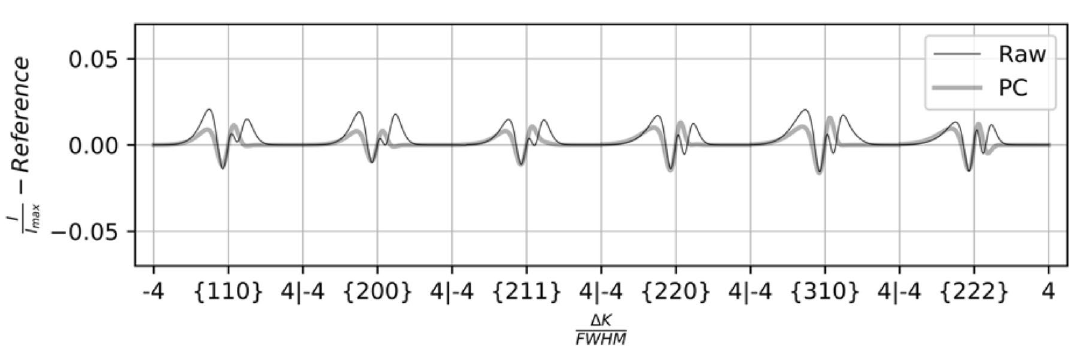
Figure 9. Actual and PC representation of the peak shape variations from a reference peak shape of a bimodal profile with a heterogeneity value of ensure high signal to noise ratio. Line profile data were collected for all deformed samples compressed to various levels of final strains. The six peaks with largest interplanar spacing were selected for analysis: {110}, {200}. {211}, {220} {310}, and {222}. Two profiles are shown for reference in Fig. 10. In Fig. 10, the relative intensity of the peaks to the background and noise is shown to be high, and the breadth of peaks was variable between samples. The increase in peak breadth was apparent with increasing macroscopic strain. The peak broadening was asym- metrical for many of the peaks analyzed. Data‑driven methods. DDD microstructure synthesis. Discrete dislocation dynamics (DDD) simulations represent a dislocated lattice as discrete dislocation lines resolved within a continuous elastic medium. The cost- liest computations of DDD are the solution of dislocation segment velocities and the solution of the lattice stress and strain within the simulated volume. The second part can be accelerated by using a fast Fourier transform (FFT) and periodic boundary conditions (instead of a finite element solver) to solve for the stress field 54,62 . These algorithmic advances increase the effective time-scale and length-scale of DDD simulations. Here, DDD simu- lations in the FFT-based framework (DDD-FFT) 54,62 were used to generate microstructures and elastic strain fields associated with relaxed dislocation networks in Ta single crystals. Elastic properties of Ta were taken from experiments reported in 63 . Dislocation motion was assumed to be isotropic and planar. Similar to BCC Fe 64 ,